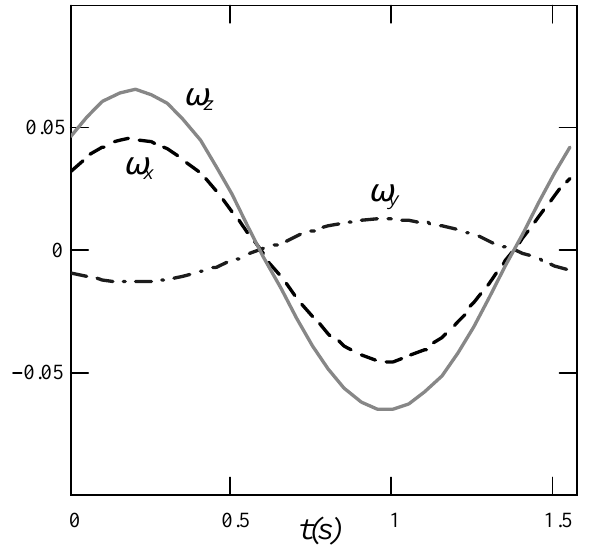
Fig. 4. Dimensionless angular velocity error ( [ ω (theoretical)] − [ ω ( calculated)] / Θ ω ).